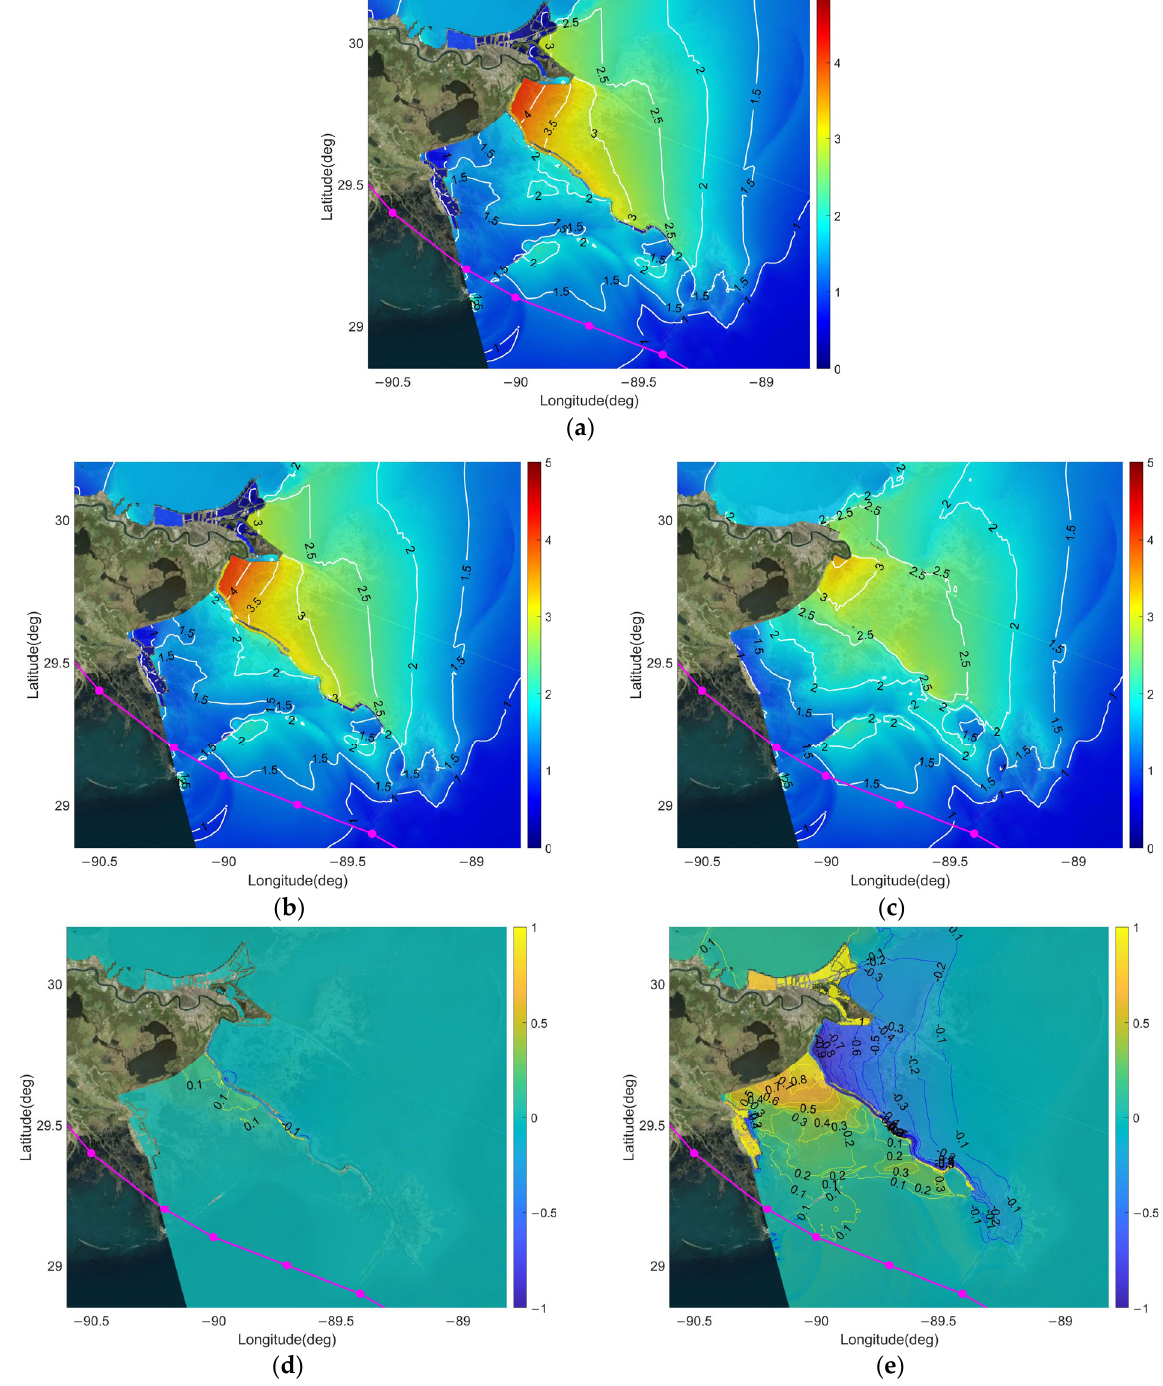
Figure 5. Maximum surge (m, NAVD88) and surge difference (m) distributions by Isaac (2012). ( a ) Base case (existing conditions); ( b ) Both-crossing case; ( c ) No-levee case; ( d ) Both-crossing case— Base case; ( e ) No-levee case—Base case. White lines denote contour lines every 1 m. Blue lines denote contour lines with negative values every 0.1 m. Yellow lines denote contour lines with positive values every 0.1 m. Magenta line with dots denotes the track of Isaac (2012).